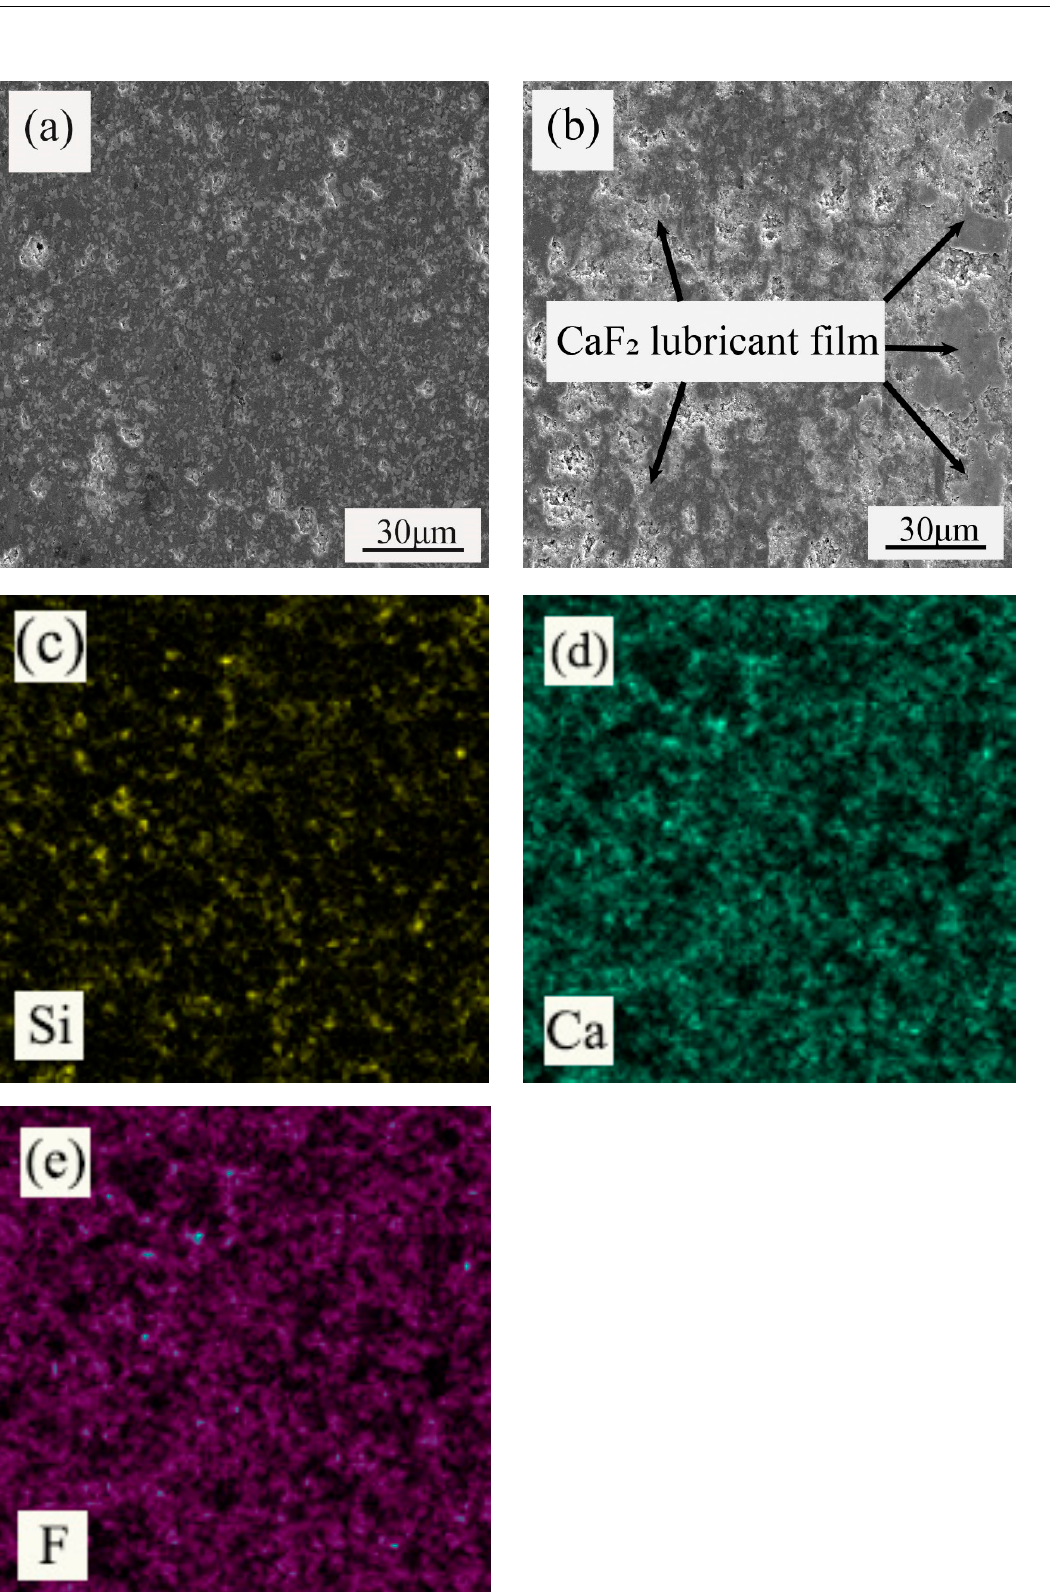
Figure 3. The wear morphology of the ATSC10 ceramic tools and elemental mapping: ( a ) the tool material before the friction and wear experiment, ( b ) the morphology of the tool material after the friction and wear experiment, ( c ) distribution of Si element, ( d ) distribution of Ca element, ( e ) distribution of F element.